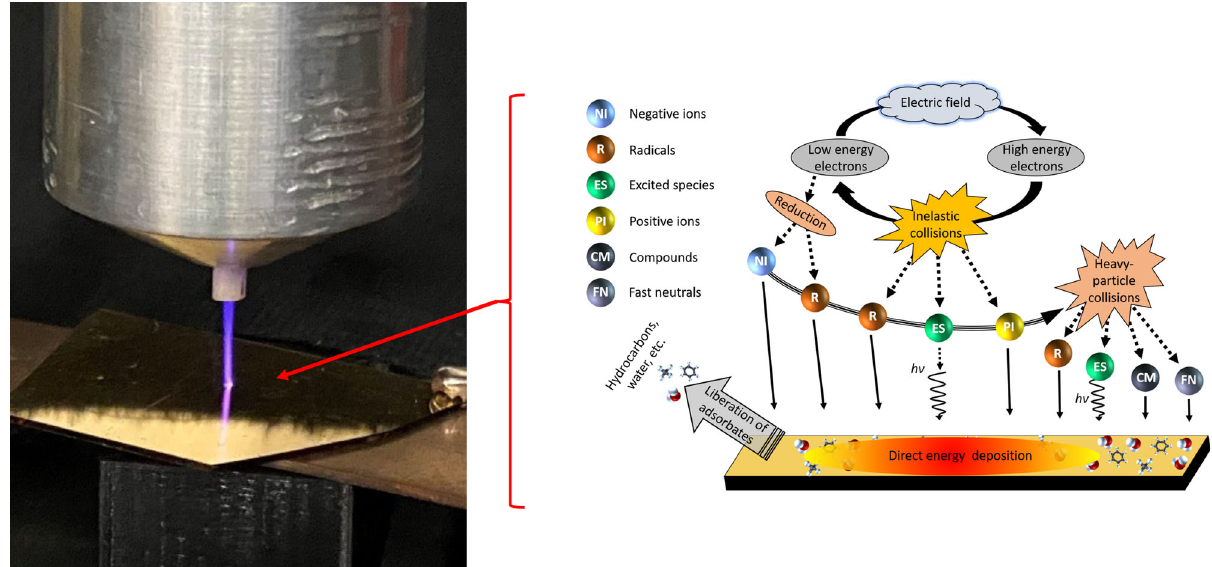
Fig. 1 Atmospheric jet interactions with metallic surface. Left. Photograph of the atmospheric plasma jet interacting with a thin Au fi lm on sapphire substrate. Right. Cartoon schematic of the various species and physical processes and resulting species produced within the jet along with their respective interactions with the metal fi